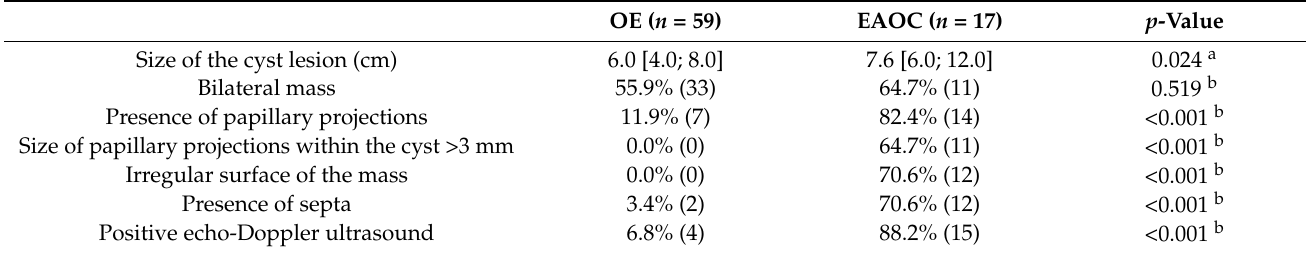
Table 2. Sonographic feature outcomes between groups.